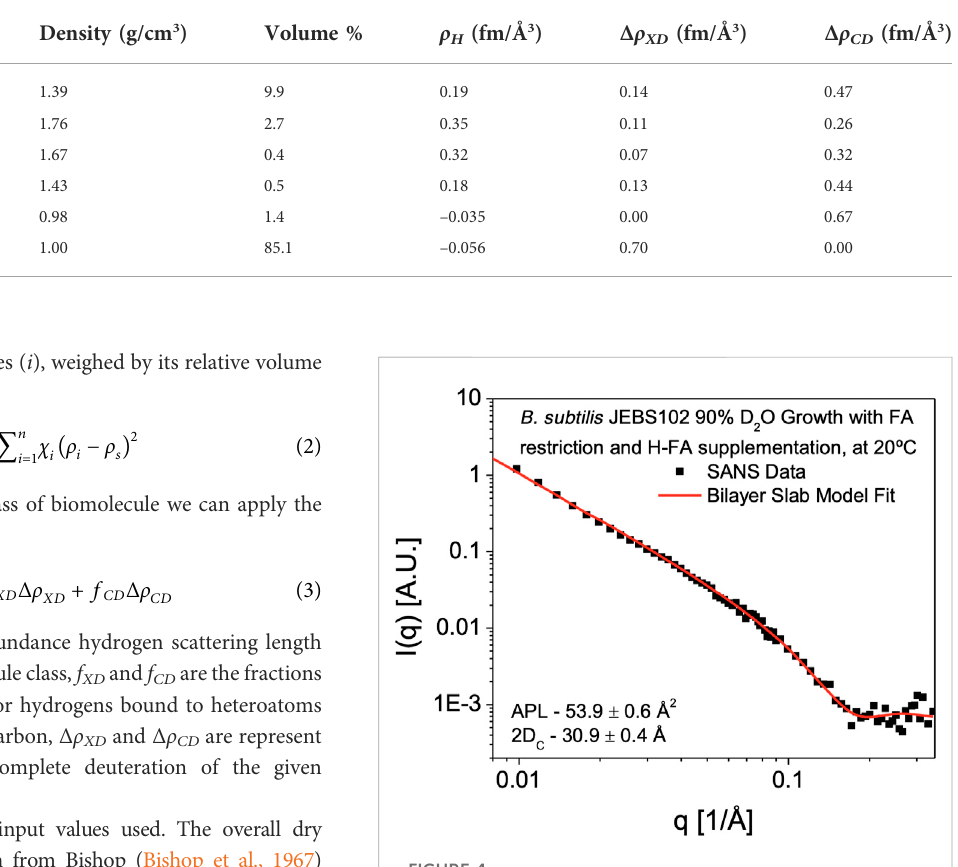
FIGURE 4 SANS Measurement of Cell Membrane hydrophobic Thickness. SANS data obtained from B. subtilis JEBS102 cells grown in90%D 2 Omedia, inducedtoblockexpression of fabF and rescued with supplementary FAs, H-anteiso-pentadecanoic acid ( a 15:0) and H-normal-hexadecanoic acid ( n 16:0) in 85% D 2